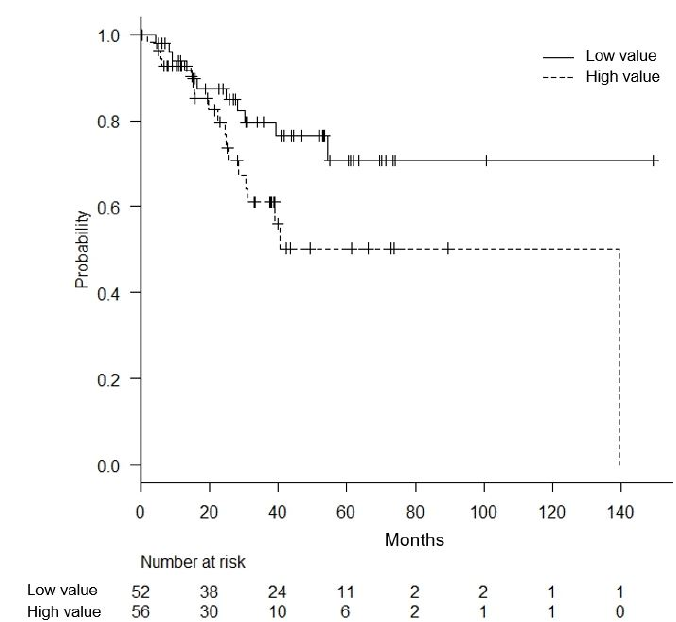
Figure 1. Impact of the radiomic factor named “LargeAreaEmphasis_LHH” on overall survival in the validation cohort. Patients were divided into two groups according to the median value of “LargeAreaEmphasis_LHH” (low value group and high value group). The univariate analysis using the log-rank test was conducted ( p = 0.044, 5-year OS of 70.7% vs. 50.3%).